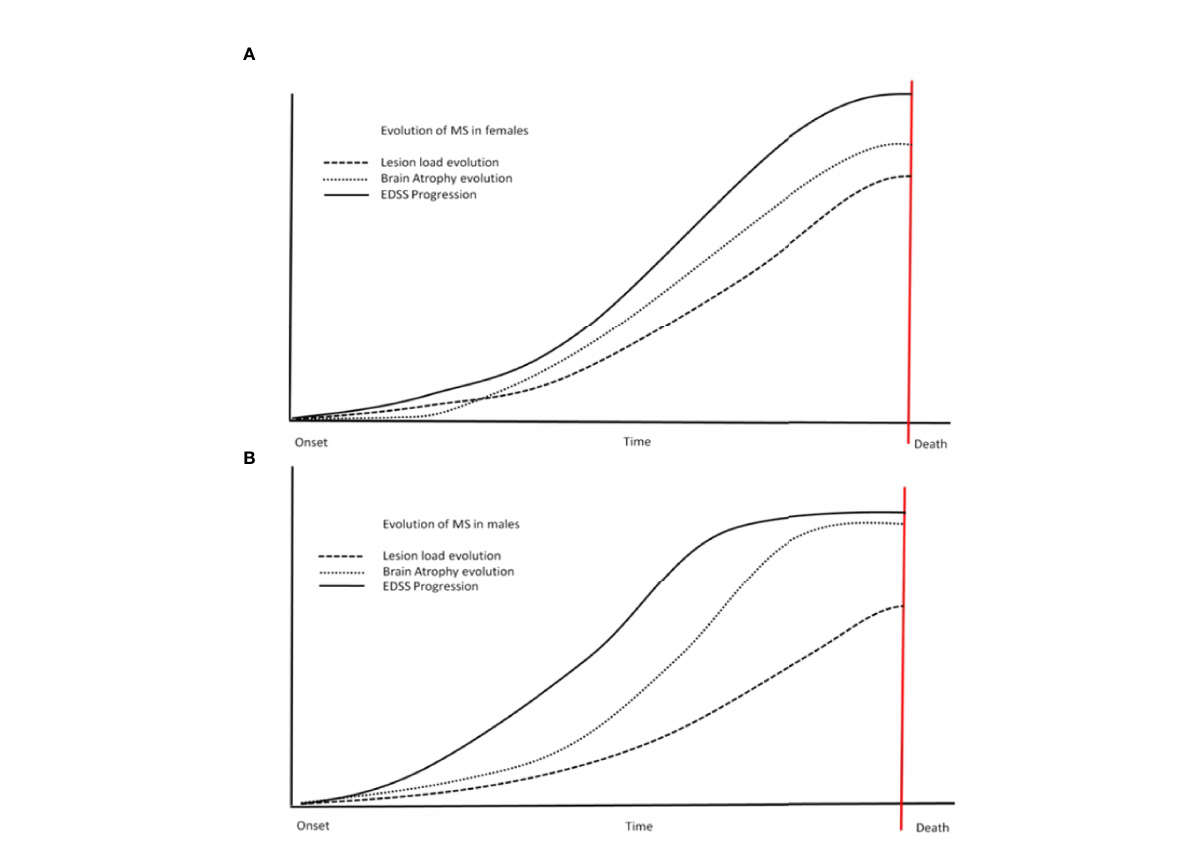
FIGURE 1 Steeper progress for males? This schematic diagram shows the differences in different variables between the sexes (females - A , males - B ). Steeper changes are more obvious in males (B) - including atrophy and EDSS. Males also reach a plateau of variables sooner than females (the scheme is not to scale regarding time and values, re fl ecting trends only). EDSS, expanded disability status